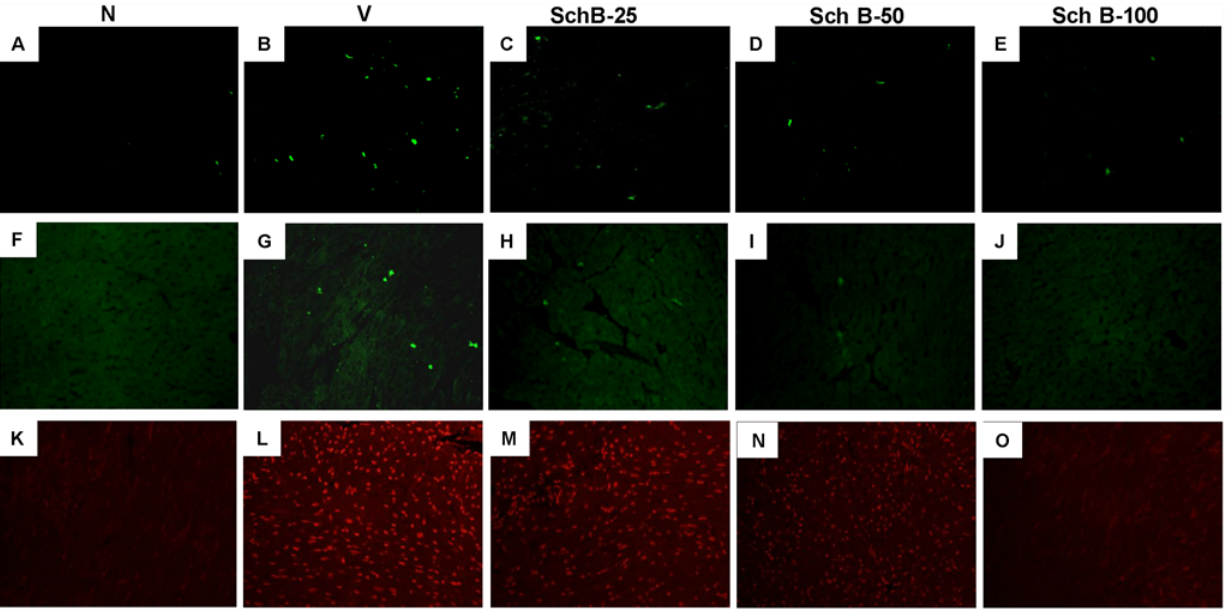
Fig 3. Sch B inhibits cardiac apoptosis, caspase-3 positive cells and superoxide production. (A – E) Myocardial tissue sections TUNEL stained for apoptotic nuclei in group N (A), group V (B) and Sch B treated mice (C – E) at 200x magnification. (F – J) Representative photomicrographs of LV sections showing caspase-3 immunofluoroscence identified by immunohistochemical staining with anti-capsase-3 antibody, group N (F), group V (G) and Sch B treated mice (H – J) (400x); Intense immunofluoroscence was detected in LV sections of group V mice. (K – O) In situ superoxide production (bright area) using dihydroethidium (DHE) staining in hearts of group N (K), group V (L) and Sch B treated mice (M – O) at 200x magnification.